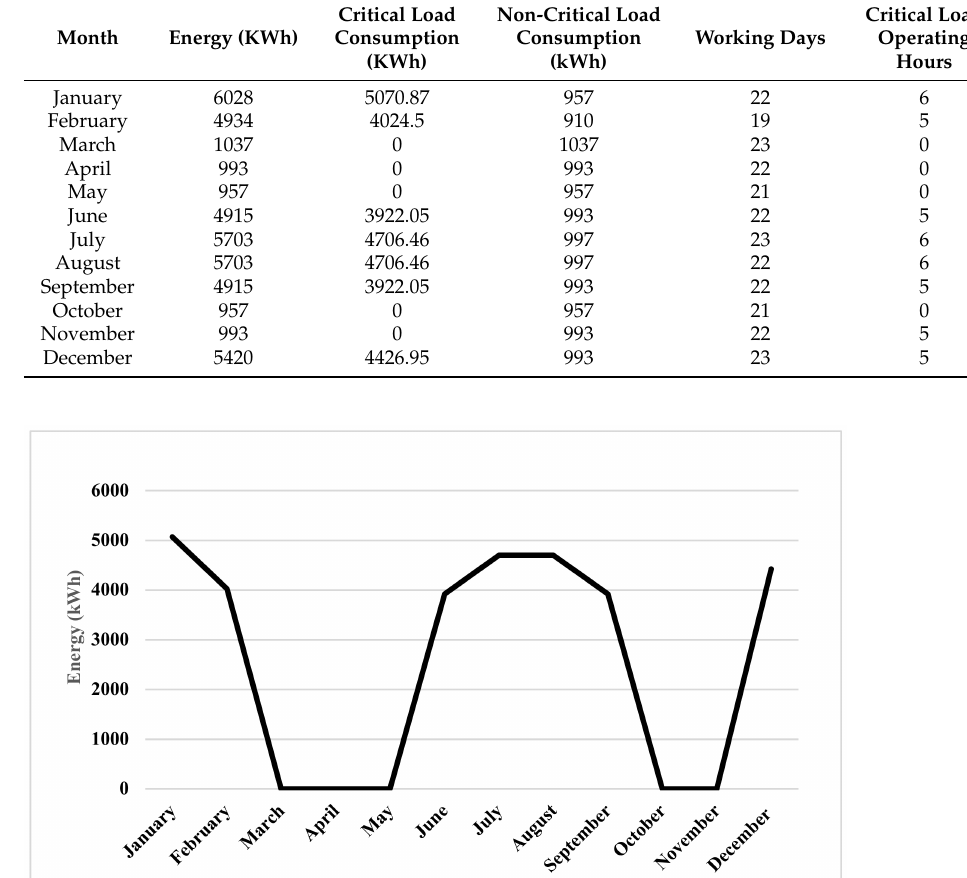
Figure 5. Critical loads annual consumption.